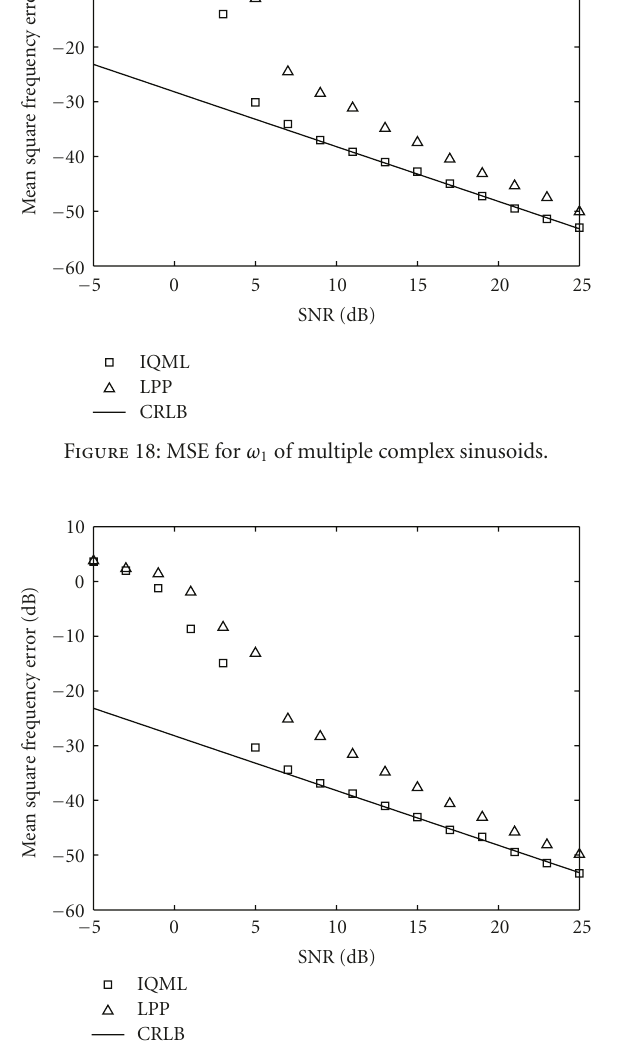
Figure 19: MSE for ω 2 of multiple complex sinusoids.